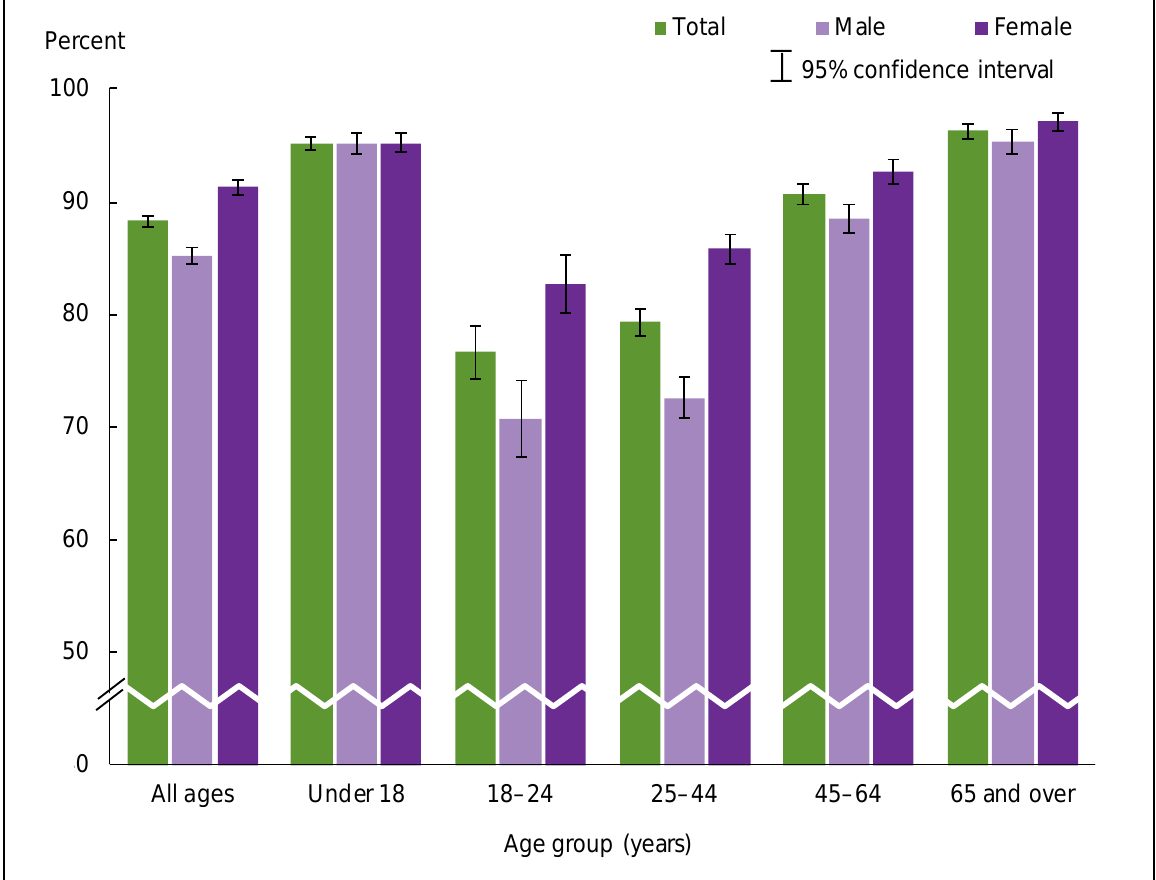
Figure 2.2. Percentage of persons of all ages with a usual place to go for medical care, by age group and sex: United States,